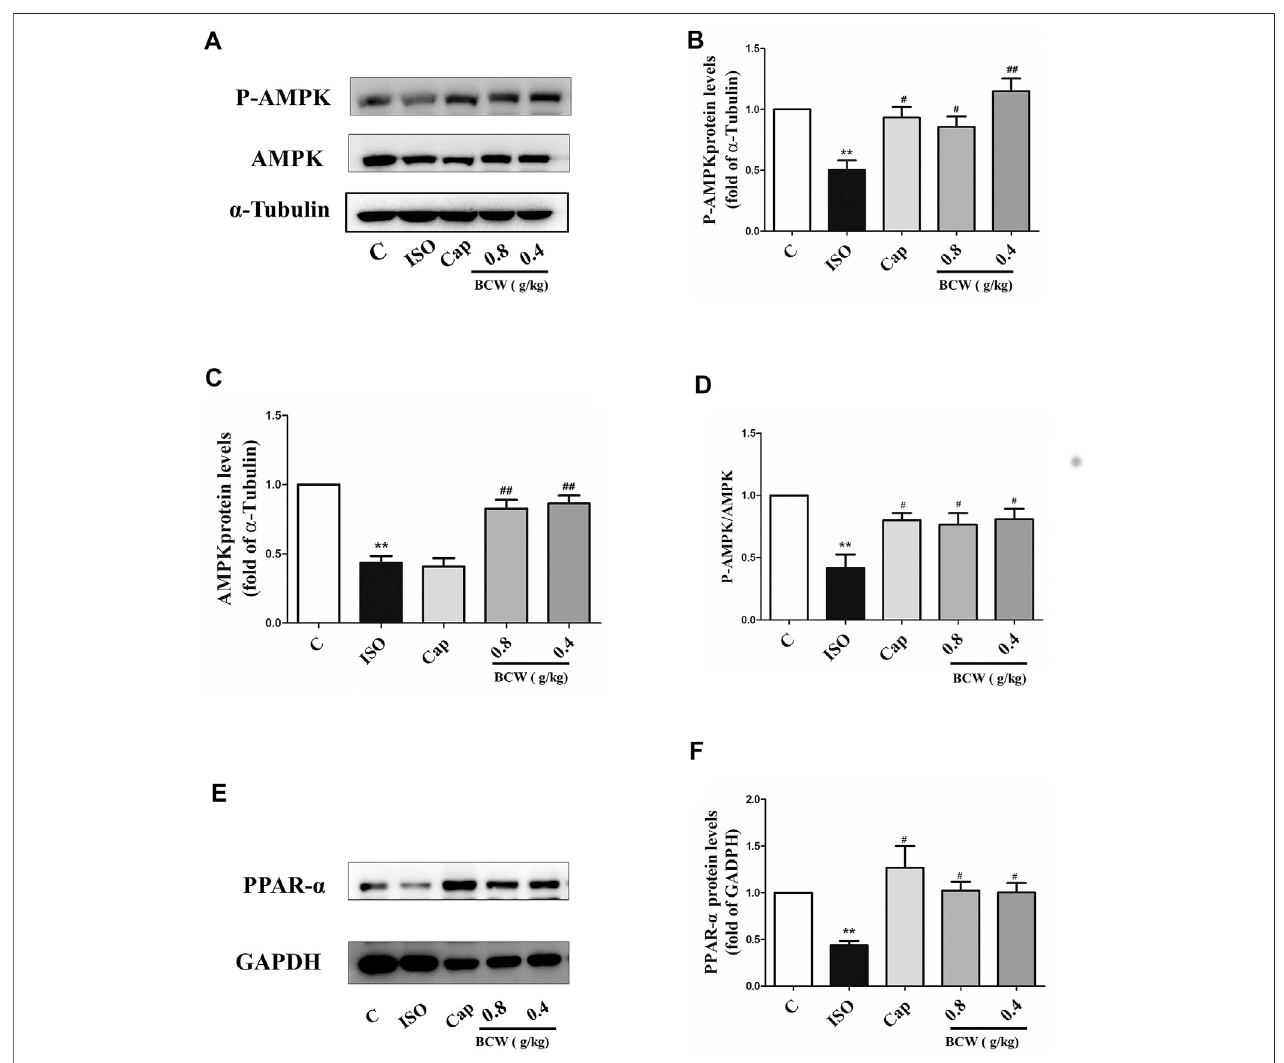
FIGURE 7 | BCW suppressed ISO-induced myocardial hypertrophy by upregulated adenosine 5 ’ -monophosphate – activated protein kinase/peroxisome proliferator – activated receptor- α (AMPK/PPAR- α ) signaling cascade. (A) The protein expression of total AMPK and phosphorylated P-AMPK was determined by Westernblotting. (B – D) Densitometric analysis ofthe immunoblot wasexpressed as a percentage of control. (E) Westernblot analysiswas conducted to determine the protein expression of PPAR- α . (F) Densitometric analysis of the immunoblot was expressed as a percentage of control. Data were normalized by α -Tubulin or GADPH for protein expression and presented as mean ± SE. * p < 0.05 vs. control, ** p < 0.01 vs. control; # p < 0.05 vs. ISO, ## p < 0.01 vs. ISO, n (cid:2) 10 in each